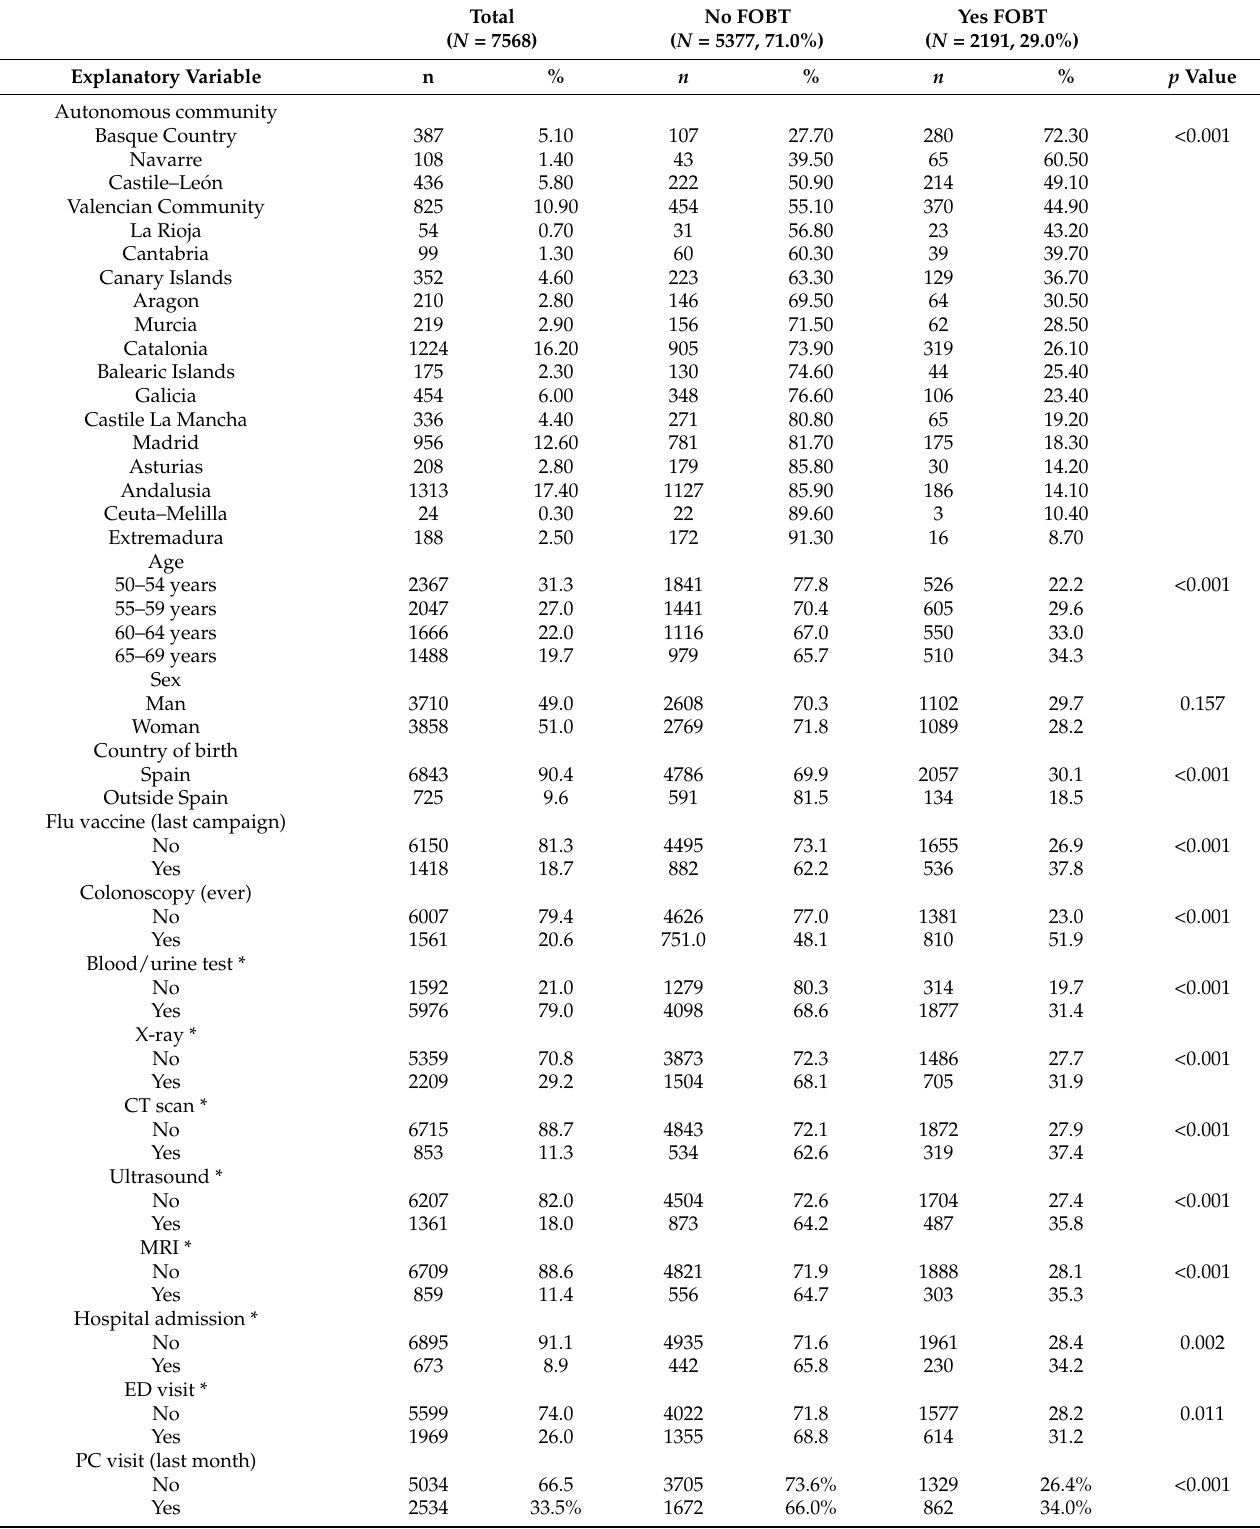
Table 1. Absolute and relative frequencies of respondents who had/had not had a faecal occult blood test (FOBT) according to selected explanatory